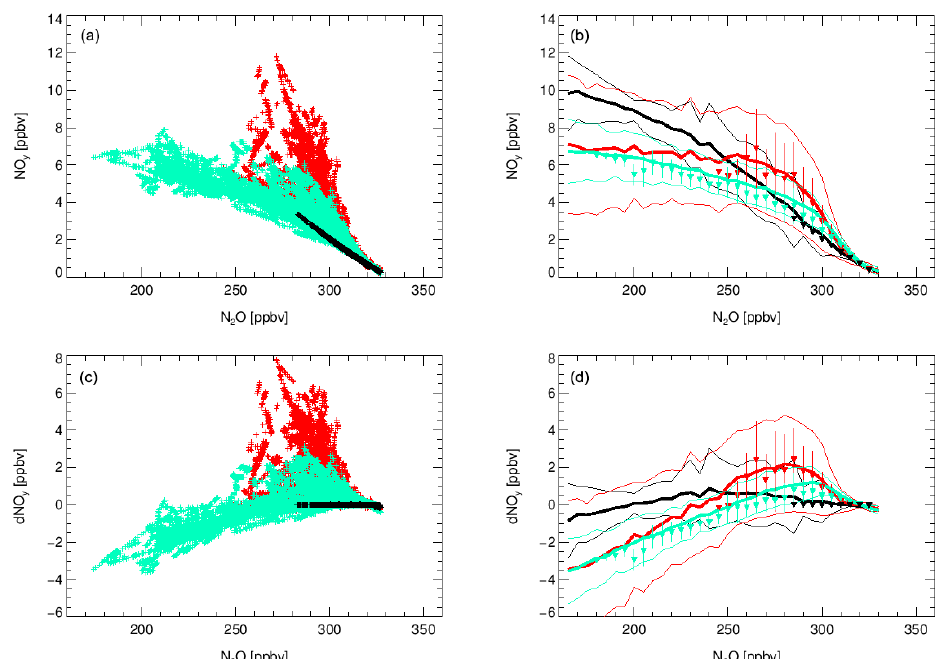
Figure 16. Correlations of NO y (a, b) and dNO y (c, d) with N 2 O from CLaMS simulations. The left panels show all dates in different colours for the three campaign phases. Data within 5min of the times 31 January 2016 14:17 and 13 March 2016 11:20UTC are omitted (see text). The right panels show the averages for N 2 O bins ± 1 σ standard deviations of these values as filled triangles with error bar signs. Also shown are the vortex average correlation for central dates of the campaign phases as thick coloured lines, ± 1 σ standard deviation is indicated as thin coloured lines.